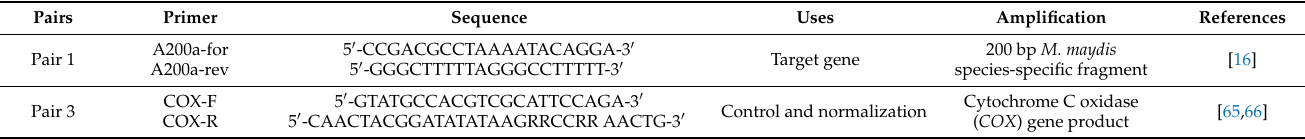
Table 3. Primers for Magnaporthiopsis maydis qPCR detection 1